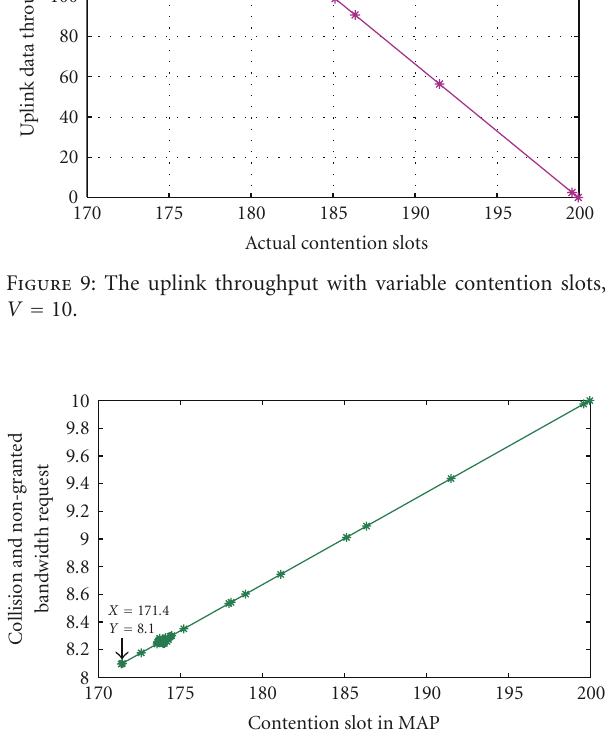
Figure 10: The retransmitted bandwidth request with variable contention slots, V = 10.